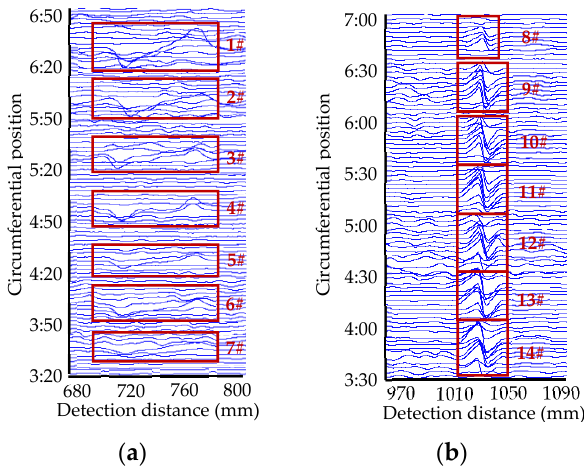
Figure 15. ( a ) Axial crack pulling test signal; ( b ) circumferential crack pulling test signal.